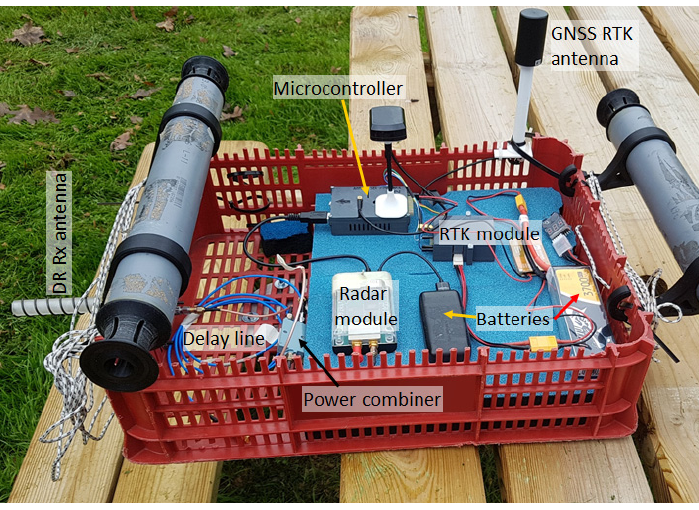
Figure 6. Picture of the devices mounted on the plastic box of the portable scanner.